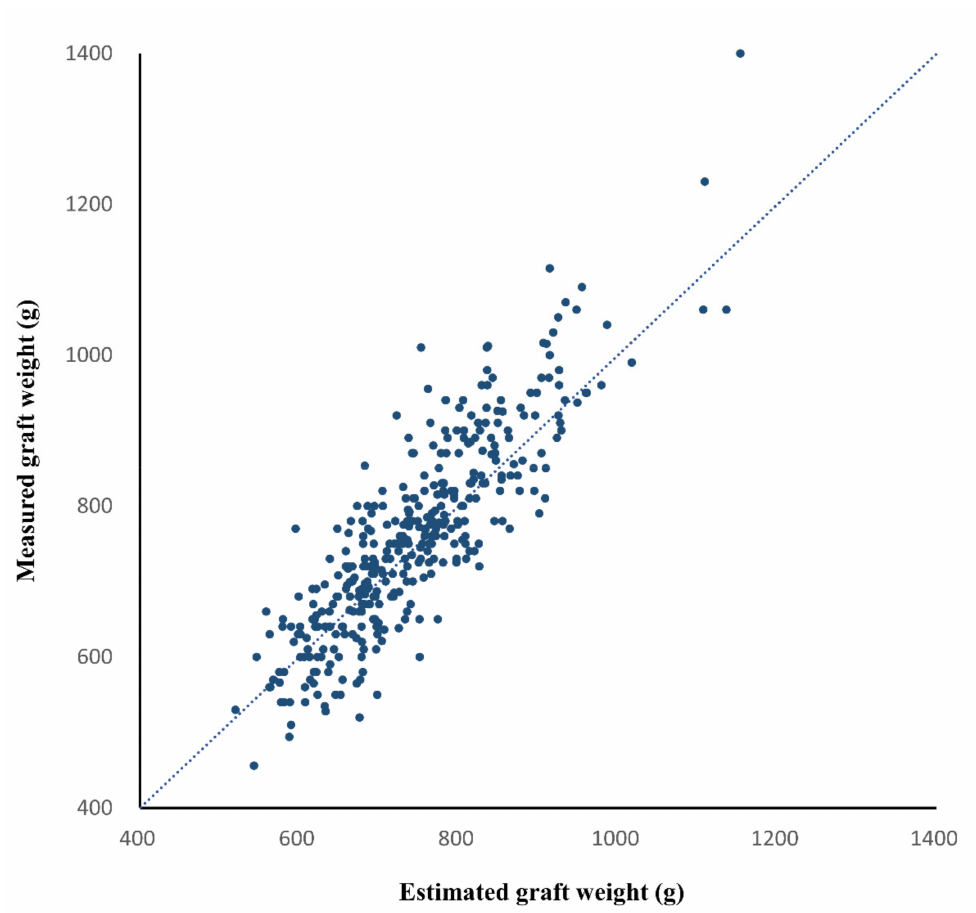
Figure 4. Scatter plot of the estimated and measured graft weights in the validation group. The dashed line is the reference line indicating complete agreement. The concordance correlation coefficient between the estimated and measured graft weights was 0.834 (95% confidence interval, 0.804 to 0.860, p <